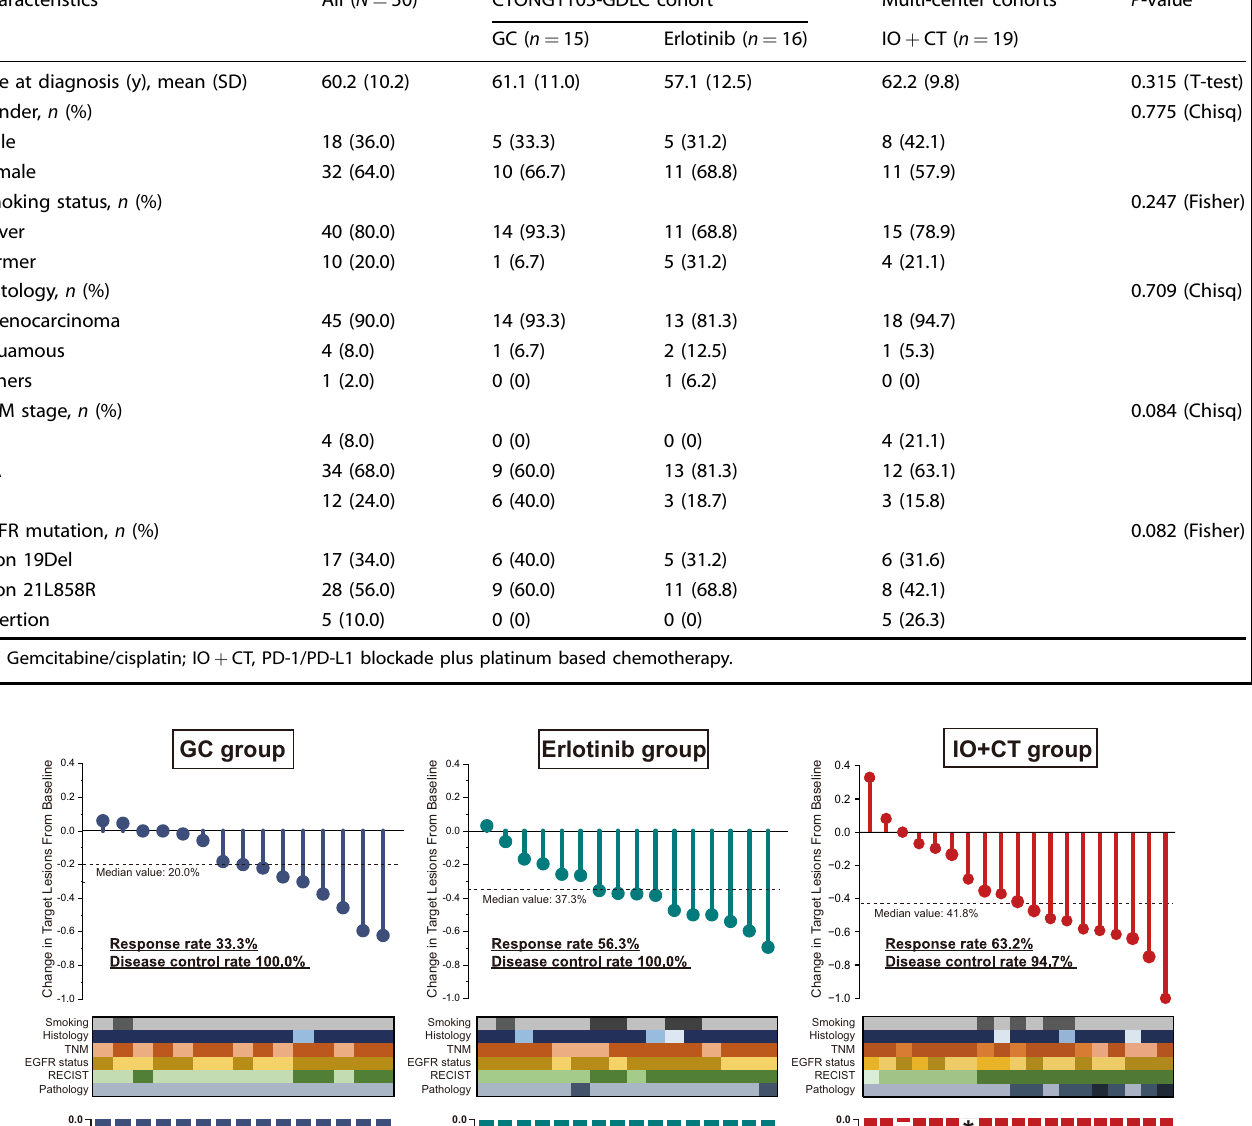
Table 2. Clincal demograchics of EGFR-mutant patients regarding different treatment modalities. Characteristics All ( N = 50)